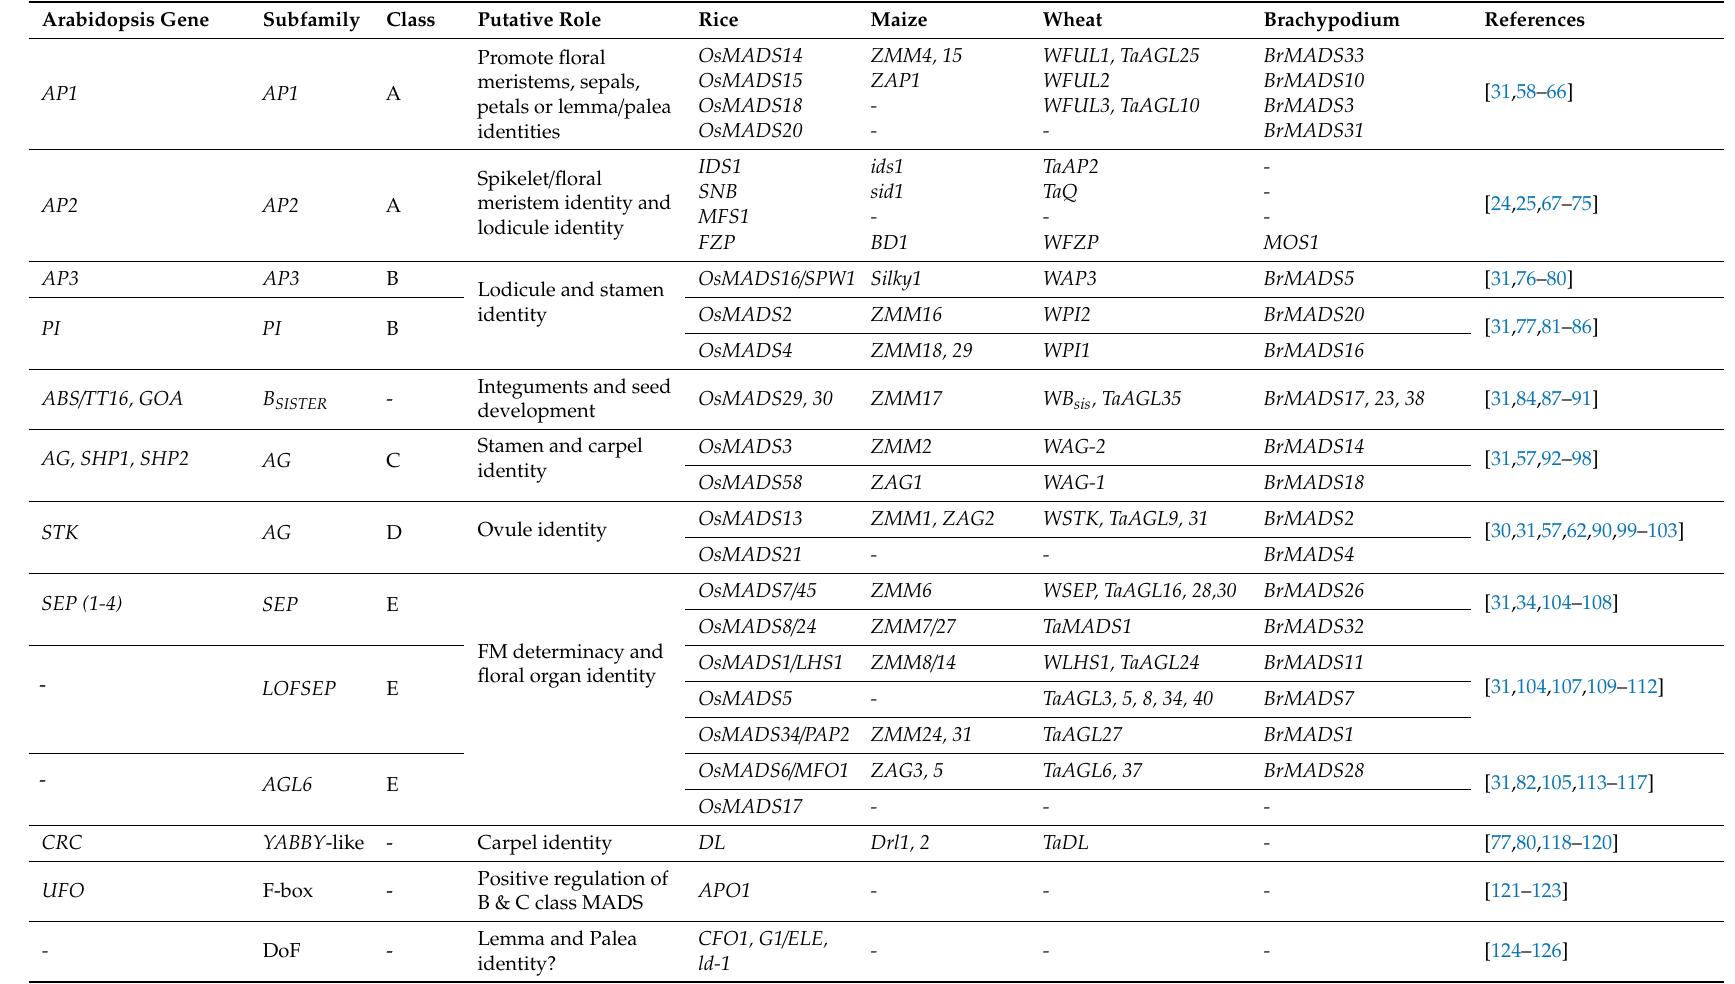
Table 1. Genes controlling floral organ identity in